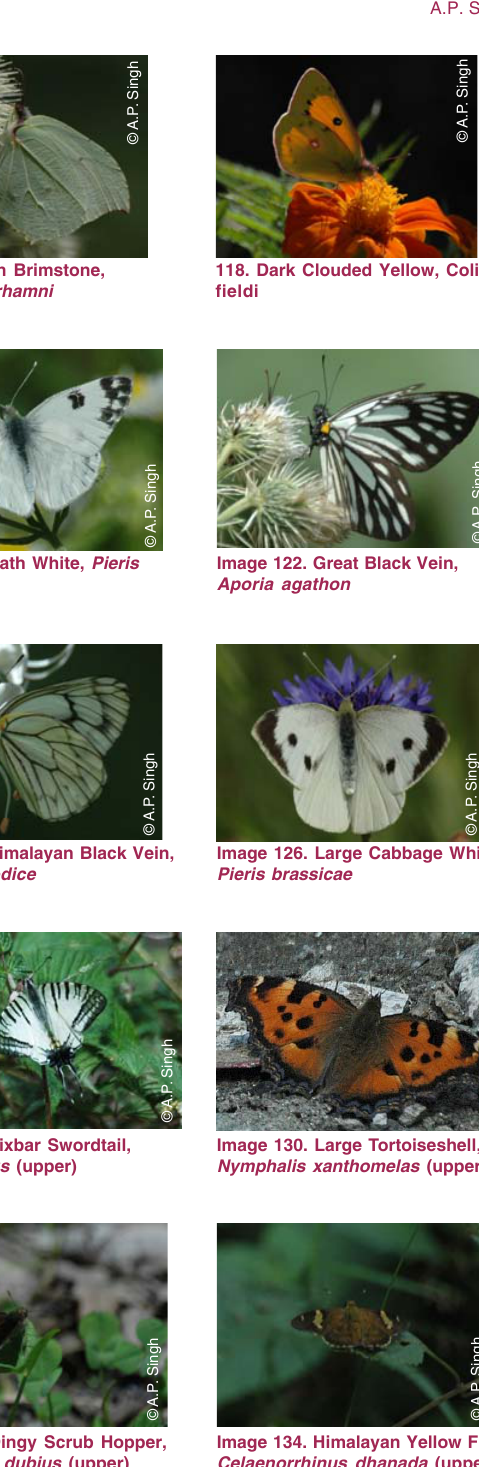
Image 133. Dingy Scrub Hopper, Aeromachus dubius (upper)